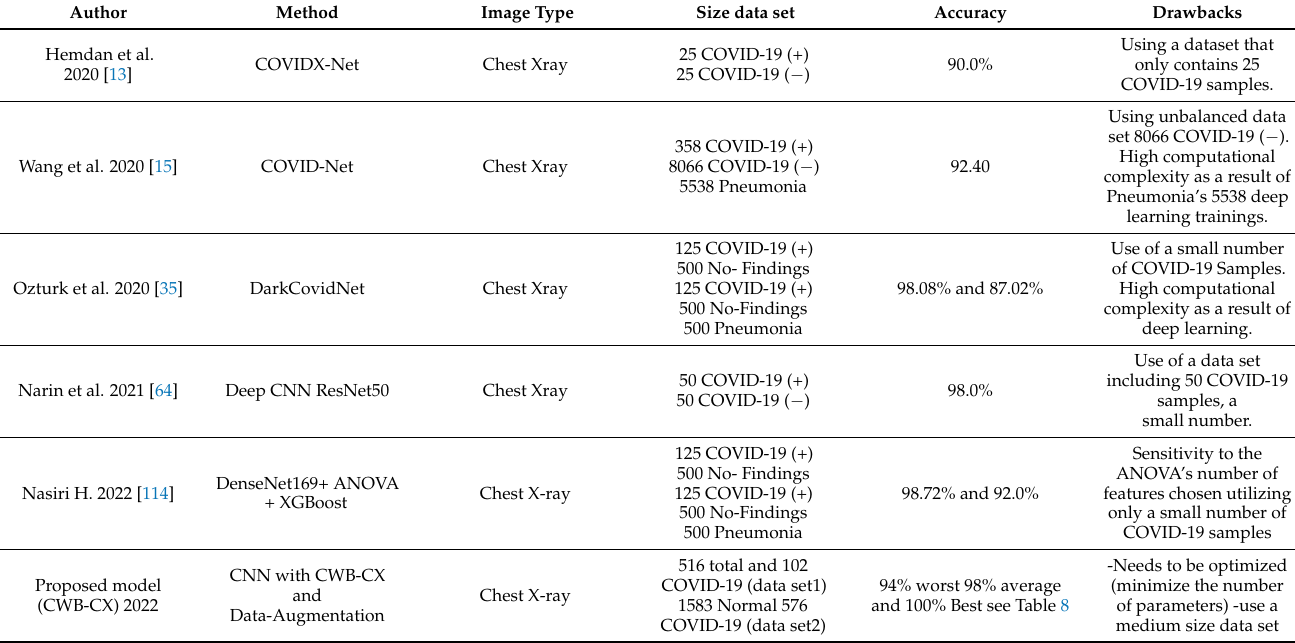
Table 7. Related work comparison only chest X-ray,